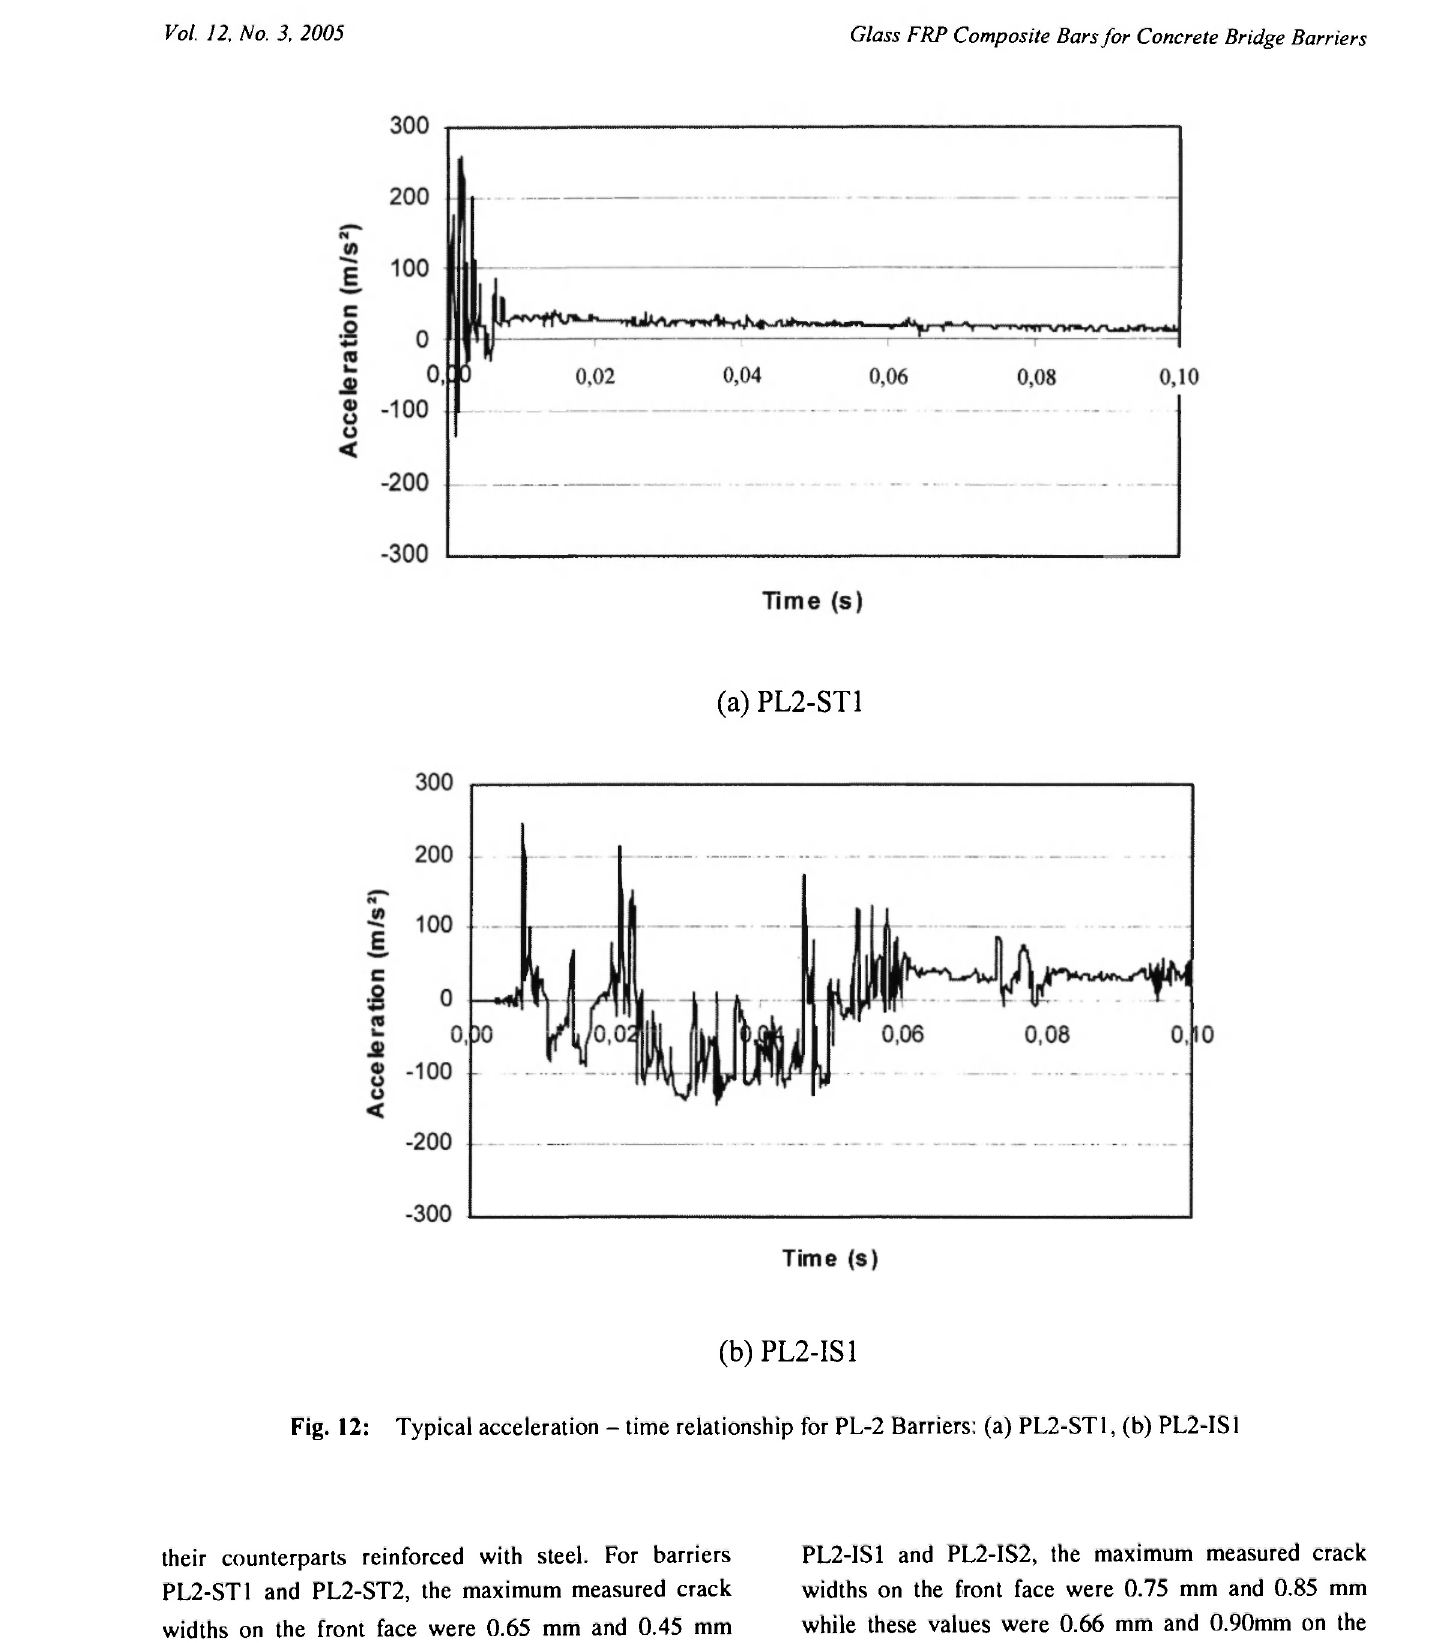
their counterparts reinforced with steel. For barriers PL2-ST1 and PL2-ST2, the maximum measured crack widths on the front face were 0.65 mm and 0.45 mm while these values were 0.70 mm and 0.46mm on the back face of the wall. On the other hand, for barriers